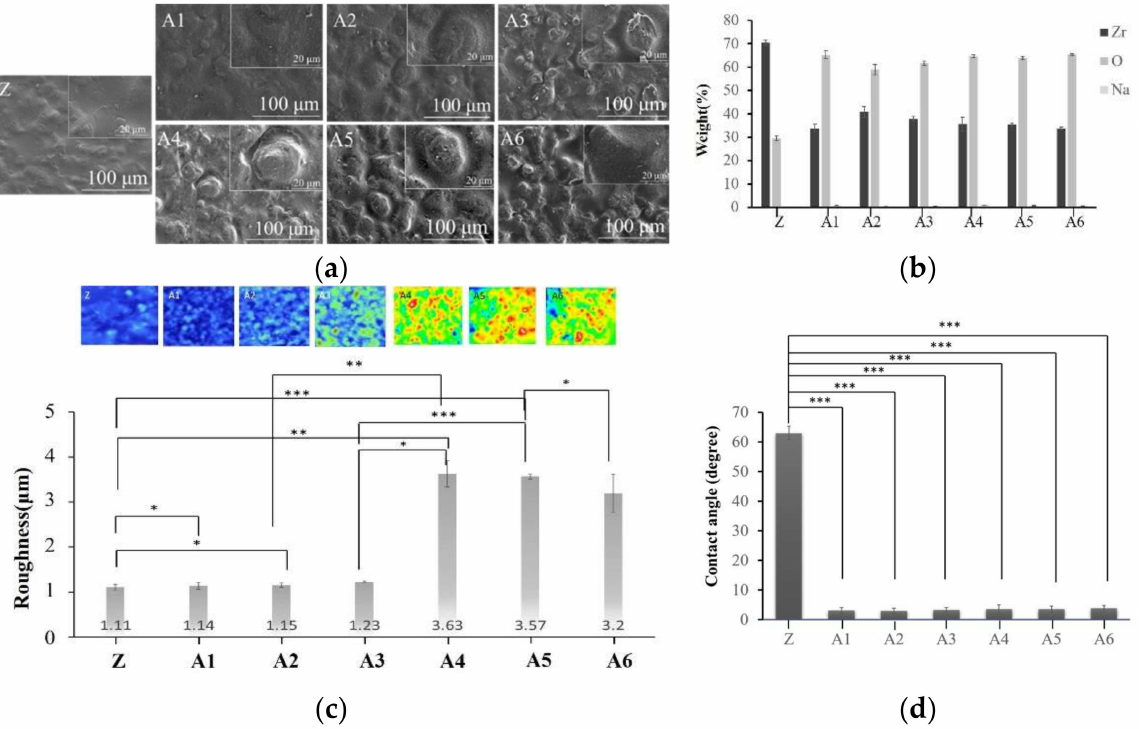
Figure 2. ( a ) The surface morphology of alkaline treatment samples was observed via SEM. ( b ) The elements of alkaline treatment samples were analyzed via EDS. ( c ) Surface roughness was analyzed via white light interferometry. ( d ) Comparison of the surface hydrophilicity after soaking in sodium hydroxide. (* p < 0.05; ** p ≤ 0.01; *** p <